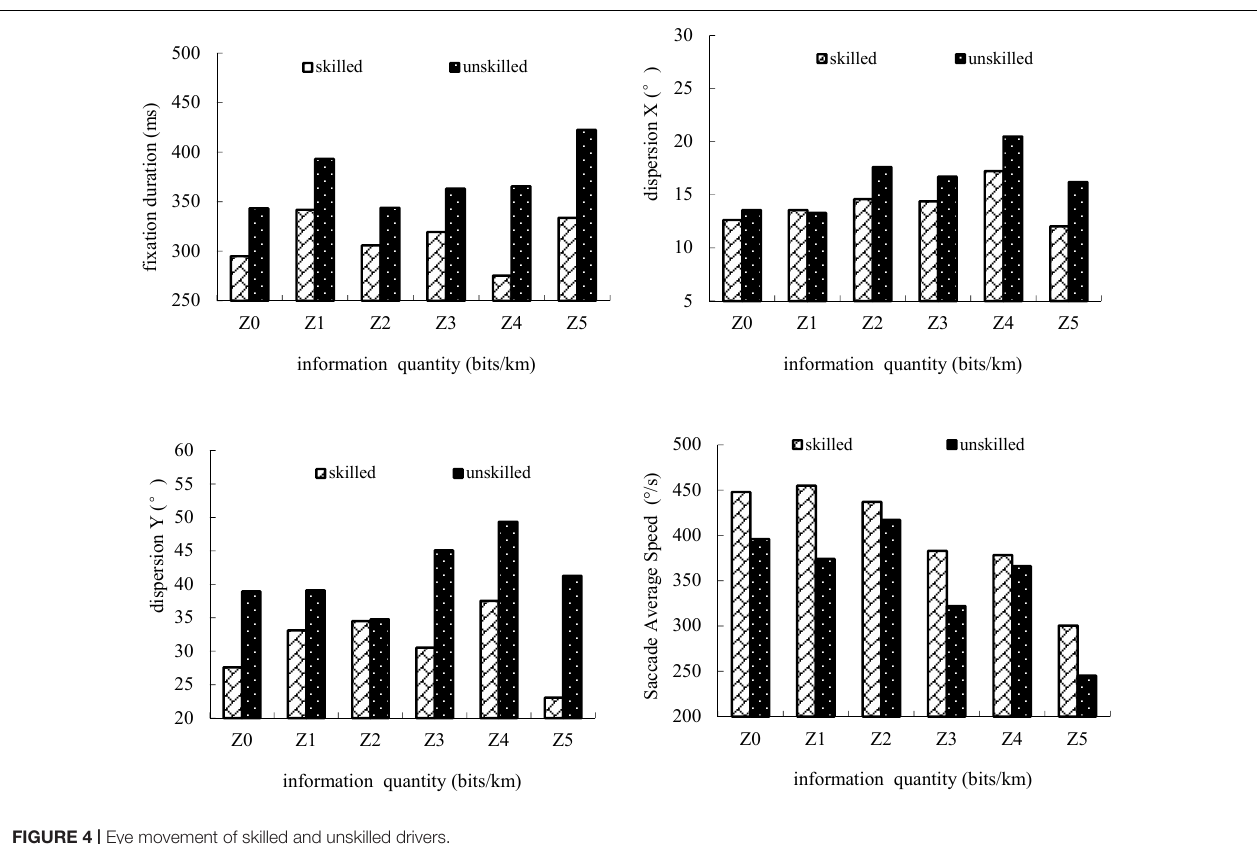
FIGURE 4 | Eye movement of skilled and unskilled drivers.